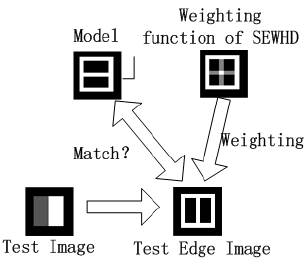
Fig. 3 Example of wrong matching using EFWHD